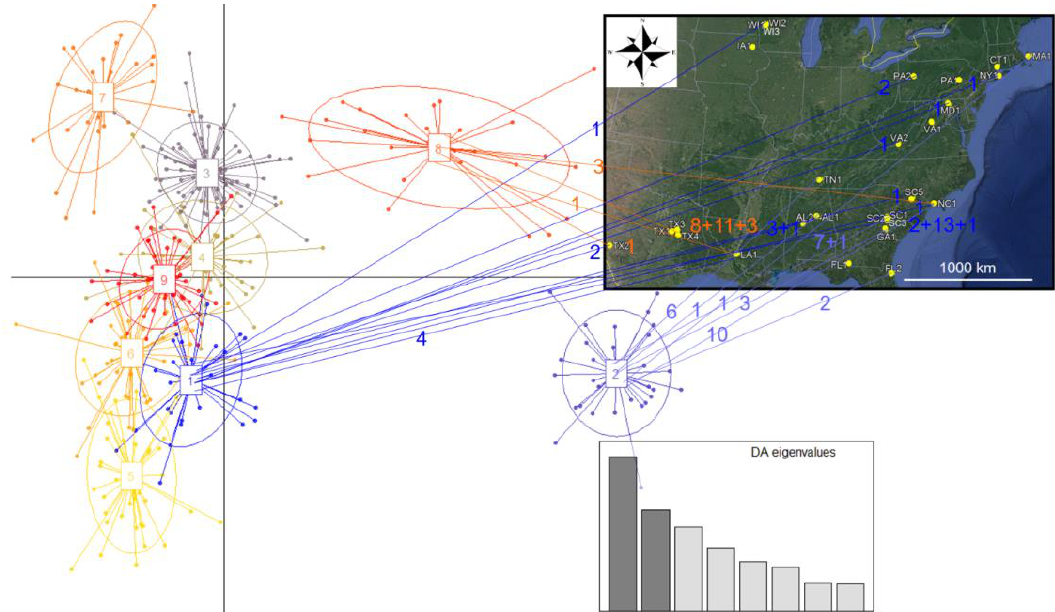
Figure 7. DAPC results with maximum number of clusters set to 10, which provides 9 clusters. Individuals' original sites and their numbers are indicated with the same color of the cluster they belong to for clusters 1 (blue), 2 (violet-blue) and 8 (orange). Even if some geographic concordance can be noticed (Cluster 8 is mainly in Texas), many individuals that belong to the same cluster originated from remote